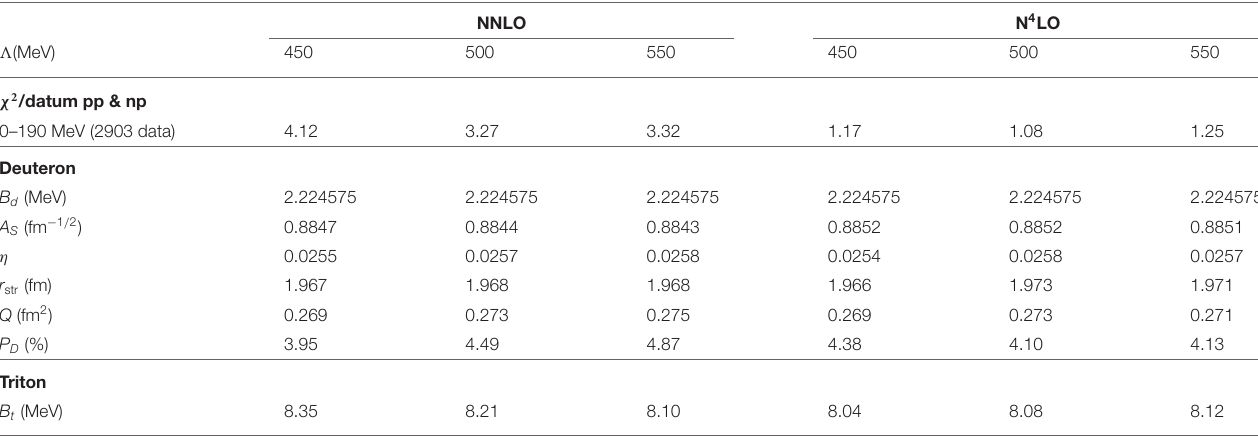
TABLE 6 | χ 2 /datum for the fit of the pp plus np data up to 190 MeV and two- and three-nucleon bound-state properties as produced by NN potentials at NNLO and N 4 LO applying different values for the cutoff parameter 3 . NNLO N 4